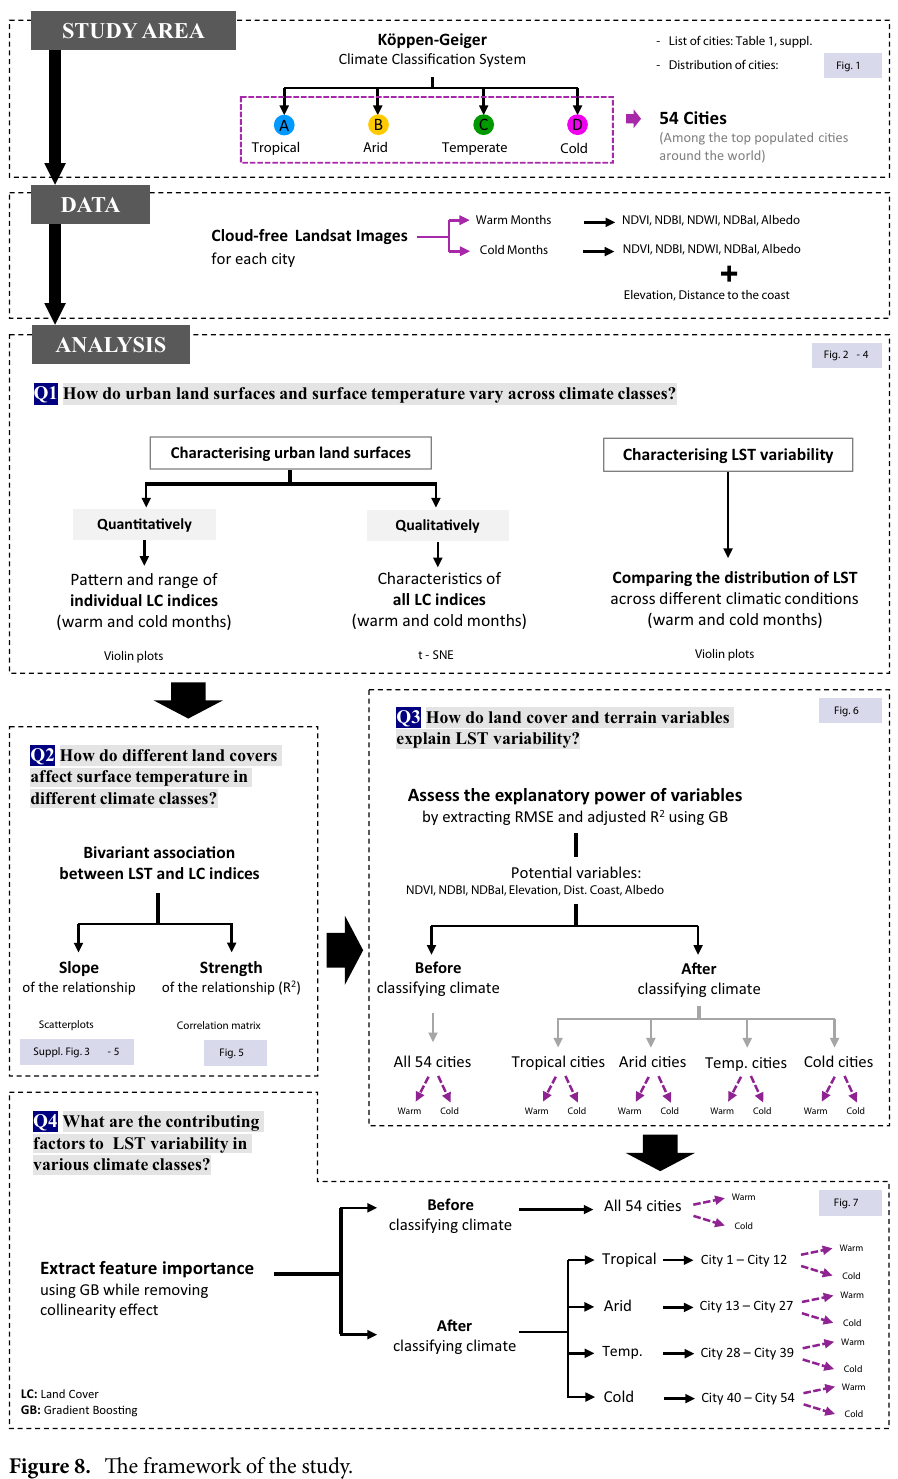
Figure 8. The framework of the